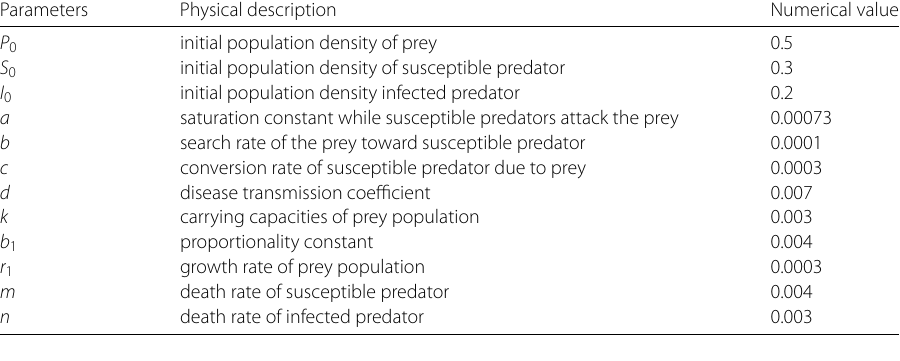
Table 1 The physical interpretation of the parameters and numerical values Parameters